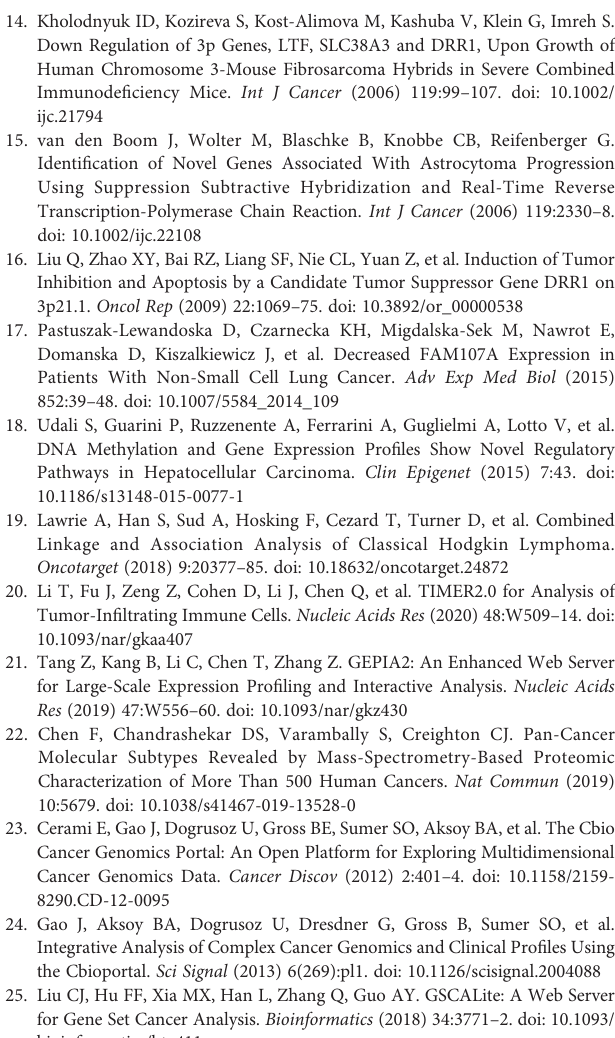
Supplementary Figure 5 | Correlation between mRNA expression levels of FAM107A and tumor mutational burden (TMB) (A) , Microsatellite instability (MSI) (B) in various cancers from TCGA database. Supplementary Figure 6 | Correlation between mRNA expression levels of FAM107A and Stromal score in various cancers from TCGA database. Supplementary Figure 7 | Correlation between mRNA expression levels of FAM107A and Immune score in various cancers from TCGA database. Supplementary Figure 8 | Correlation between mRNA expression levels of FAM107A and ESTIMATE score in various cancers from TCGA database. Supplementary Figure 9 | Knockdown of FAM107A promoted the proliferation, migration and invasion of renal cancer cells. (A) The expression level of FAM107A mRNA was evaluated in 293T and various renal cancer cell lines by qRT-PCR. (B) 786-O and 769-P cells were transfected with si-FAM107A, the knockdown was validated by Western blot. The proliferation of renal cancer cells was examined by CCK-8 assay (C) and colony-formation assay (D) . (E) The migration of renal cancer cells was examined by wound healing assay. (F) The invasion of renal cancer cells was explored by transwell assay. Data are shown as mean ± SD. *P<0.05; **P < 0.01; ***p <